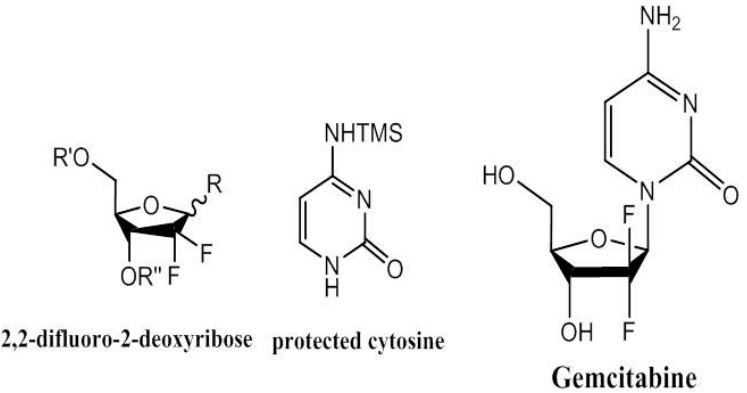
Figure 3. Gemcitabine obtained by a combination of protected and activated pentose and a substituted cytosine base.